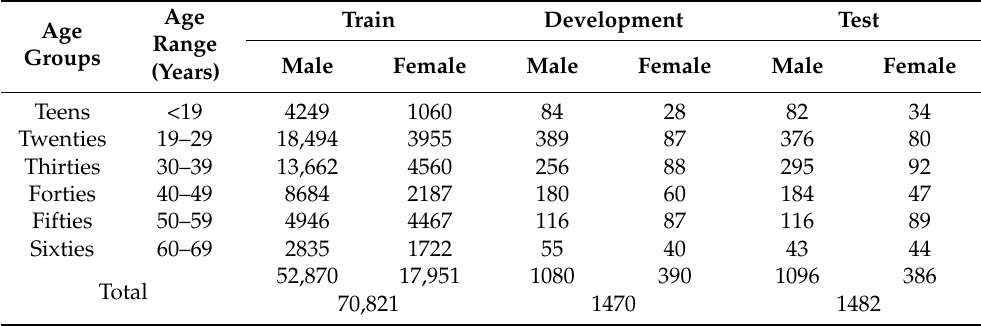
Table 2. A detailed description of the utilized English subset of the Common Voice dataset.